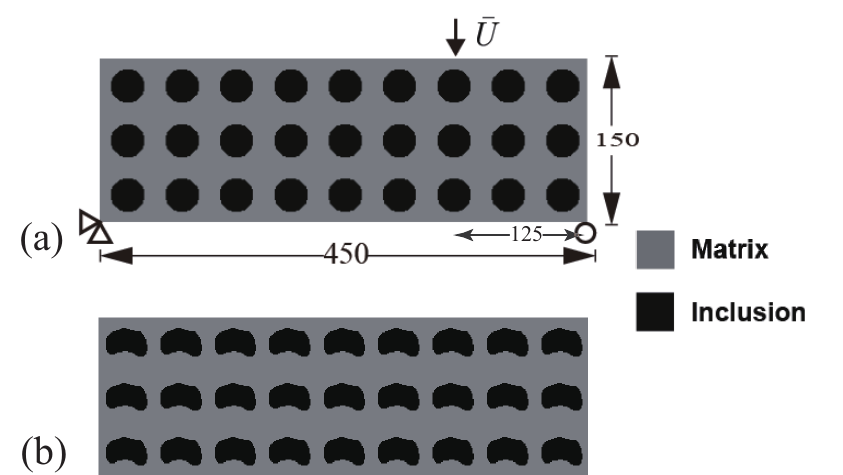
Figure 10. A periodic composite without initial crack subjected to non-symmetric three-point bending: ( a ) boundary conditions and geometry of the initial design; ( b ) optimized design.